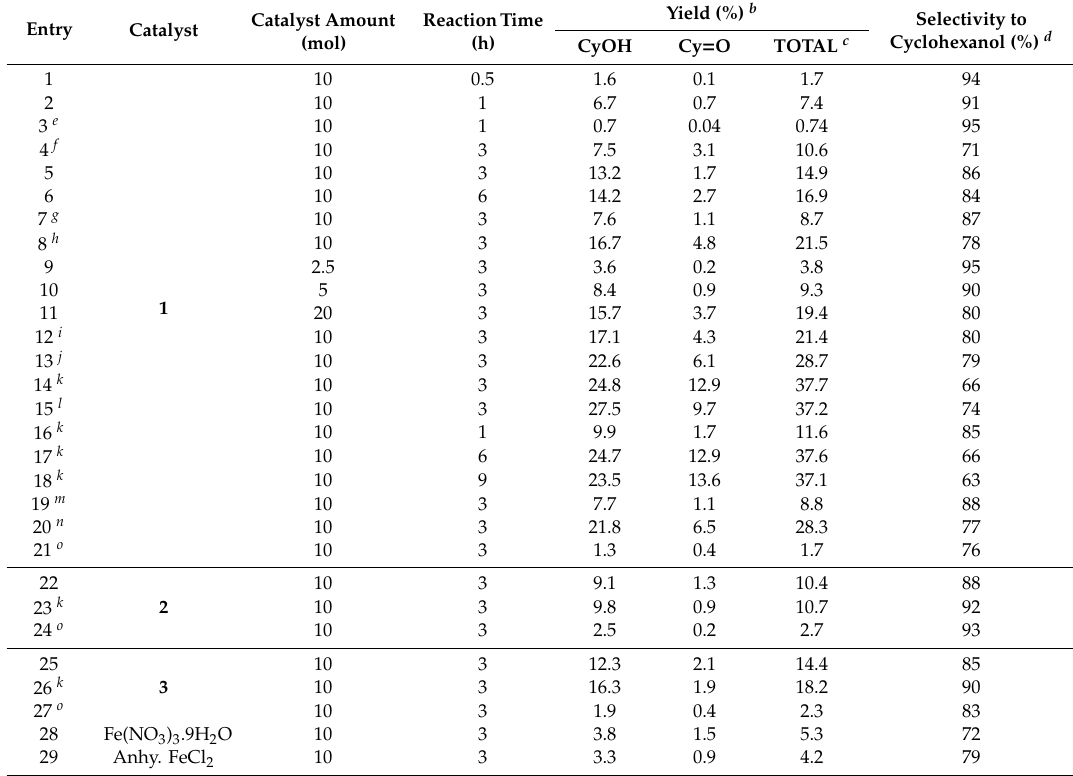
Table 2. Data a for the MW-assisted oxidation of cyclohexane by catalysts 1 - 3 using TBHP (70% aqueous) as an oxidant.